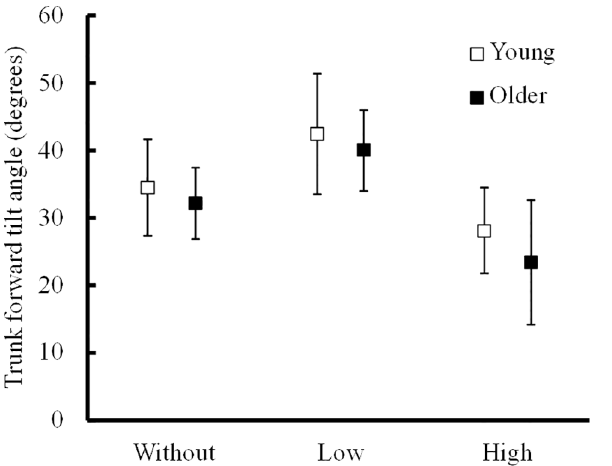
Fig 2. Average and standard deviation of forward tilt angle of trunk in young adults and care-needing older adults during STS movement. The handrail position had similar effect on the forward tilt angle of trunk for the two groups, showing no significant